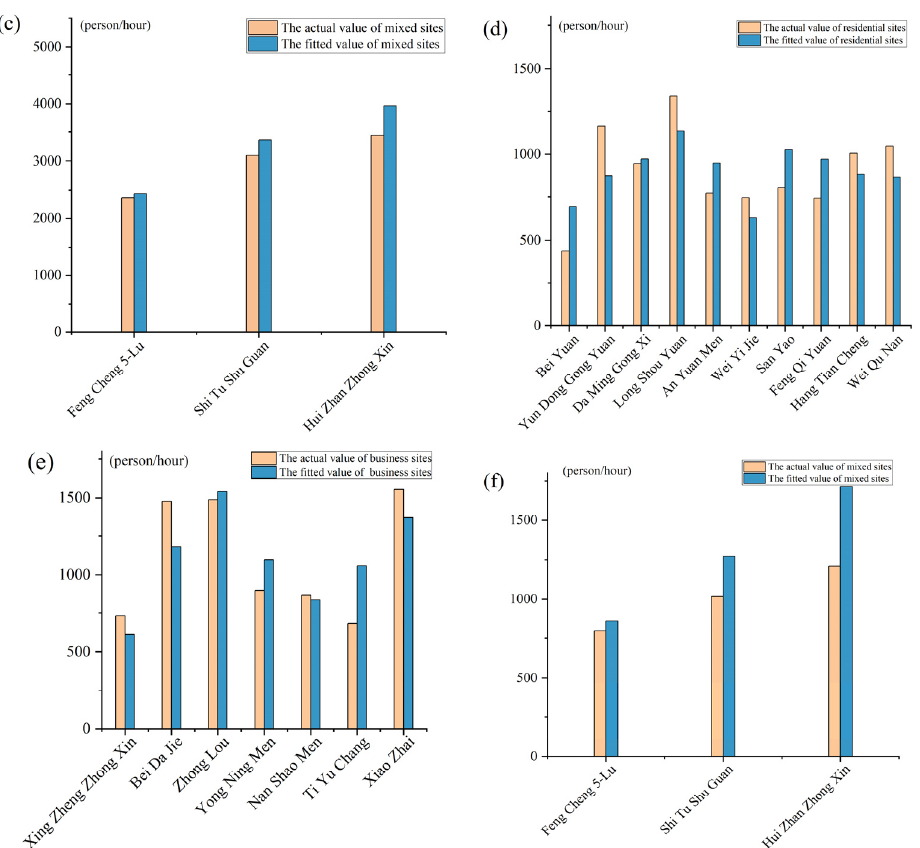
Figure 10. ( a – c ) the actual and fitted passenger flow values during peak periods; ( d – f ) the actual and fitted passenger flow values during off-peak periods. Table 17. Mean absolute percentage error (MAPE).